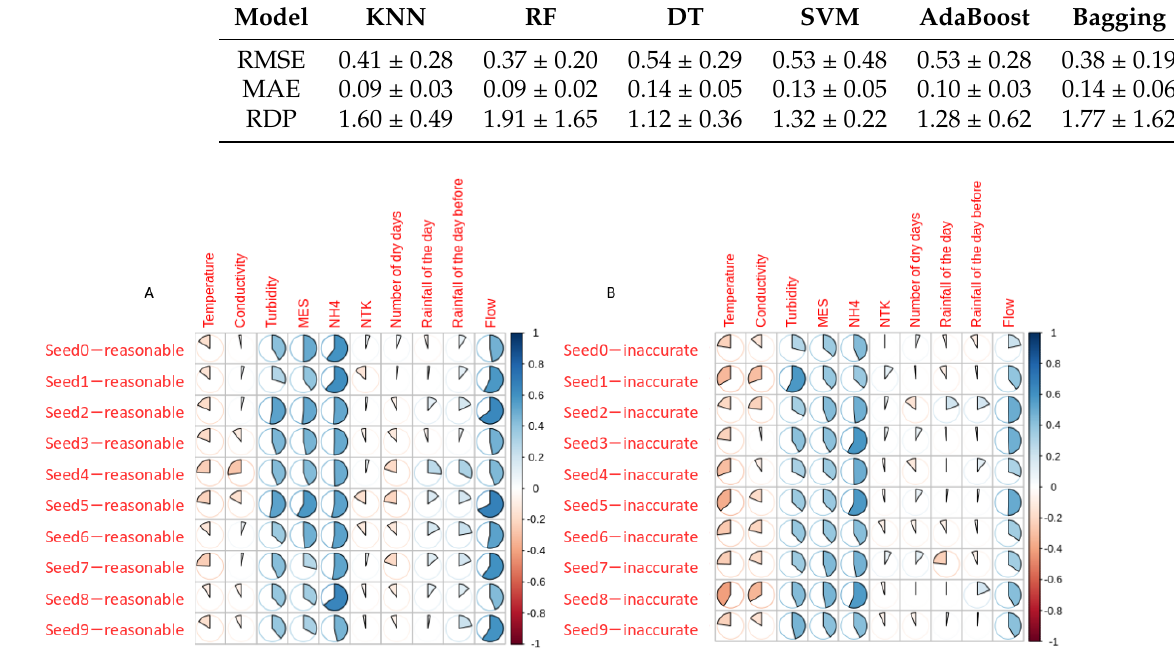
Table A2. Average and standard deviation of the statistic metrics (RMSE, MAE, RDP) obtained with each model during the ten testing trials.